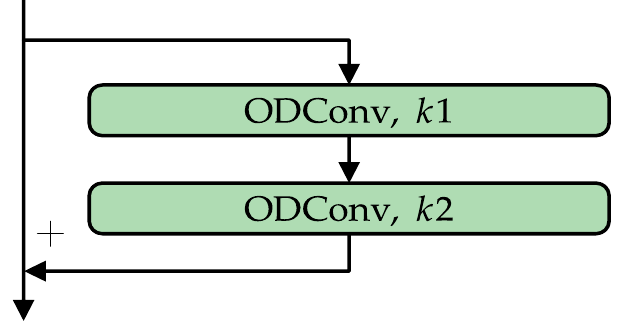
Figure 6. Schematic illustration of block with different kernels. Table 3. Results of different kernel size in block.